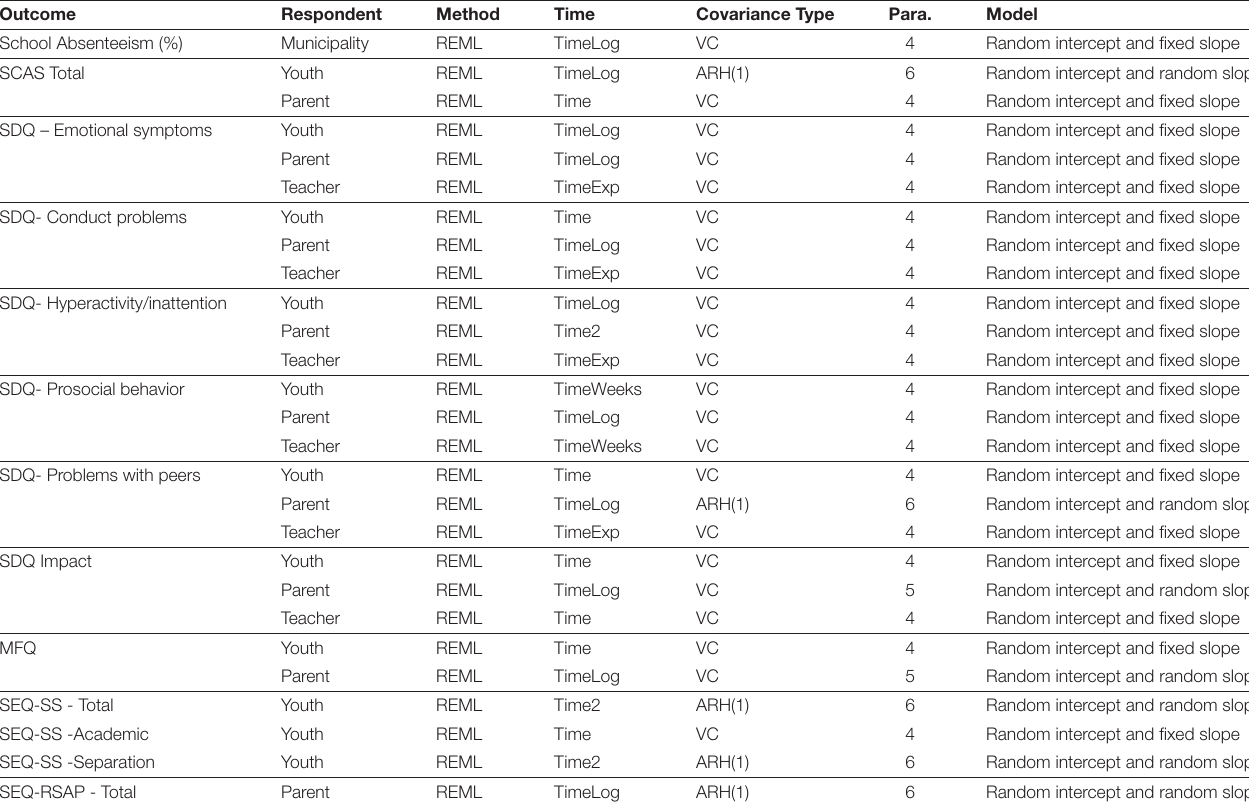
TABLE 2 | Overview of the initial testing of the variables in the mixed linear